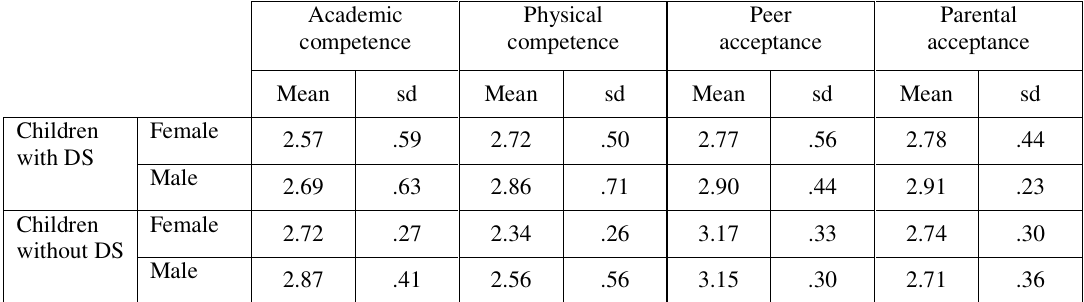
Descriptive score values from young students with and without Down Syndrome by gender Academic Physical competence competence